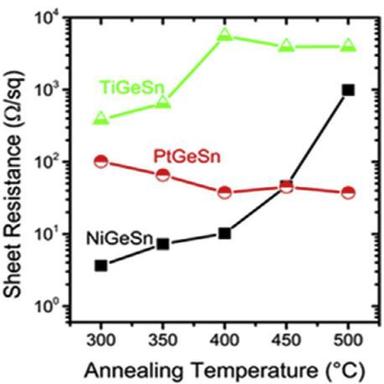
Sheet resistance for Ni, Ti and Pt stanogermanides as a function of the formation temperature.